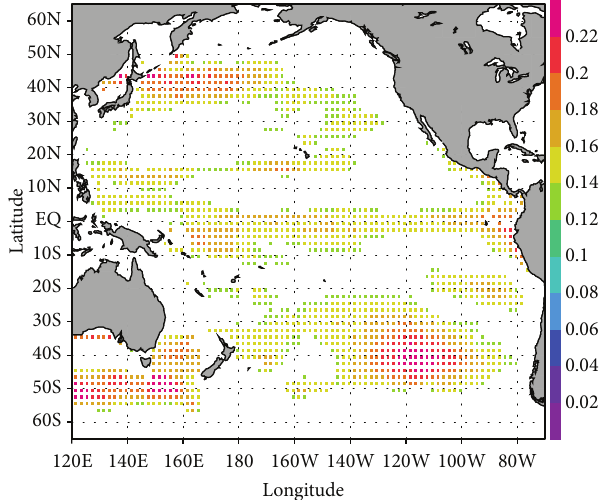
Figure 5: The same as Figure 4(b) but for the 1652 highest sensitivity values (see Section 3.2 in the text for